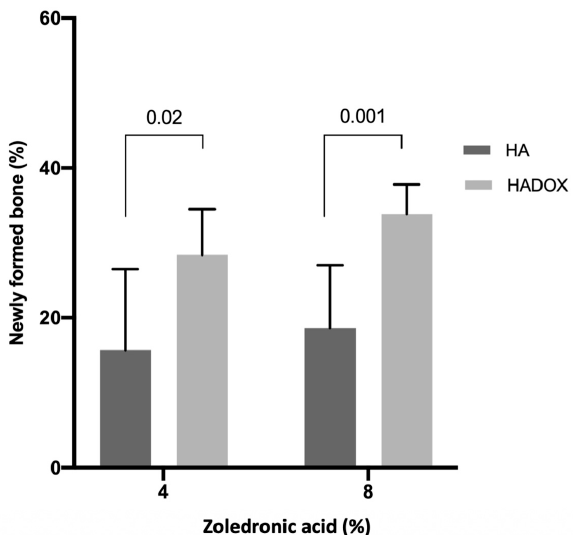
Figure 7. Newly formed bone in the Sham group (without ZA treatment), Sham 4%ZA and Sham 8% ZA treatments. The values are presented as mean ± C.I. The statistical differences between treatments are represented by horizontal bars. There were no statistical differences between clot 4% ZA and clot 8% ZA (ANOVA and Tukey’s post-test, p <0.05).